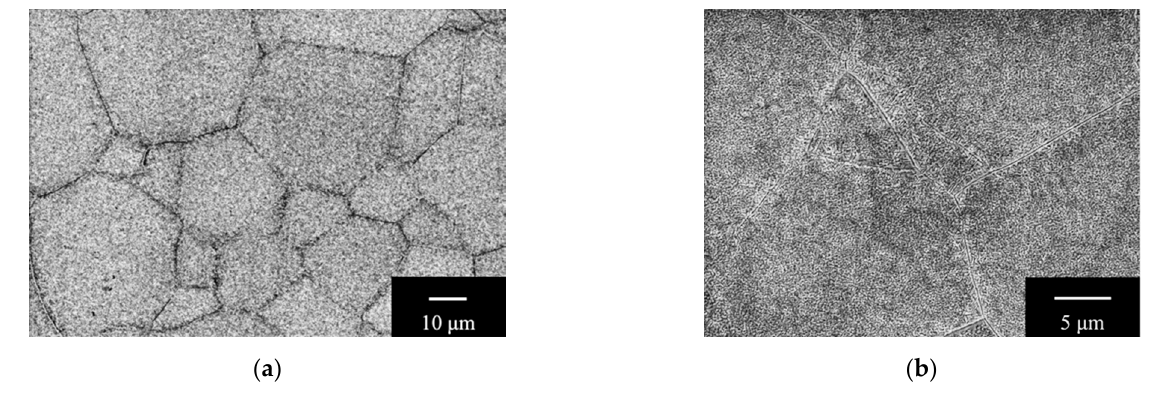
Figure 1. Microstructure of the applied Ti-22V-4Al alloy with a homogenous and fine α -phase precipitation from SEM analysis: ( a ) low-magnification and ( b ) high-magnification images. The material was polished to a mirror finish and then etched with Kroll’s reagent (HF:HNO 3 :H 2 O = 1:2:50) for 8–10 s.